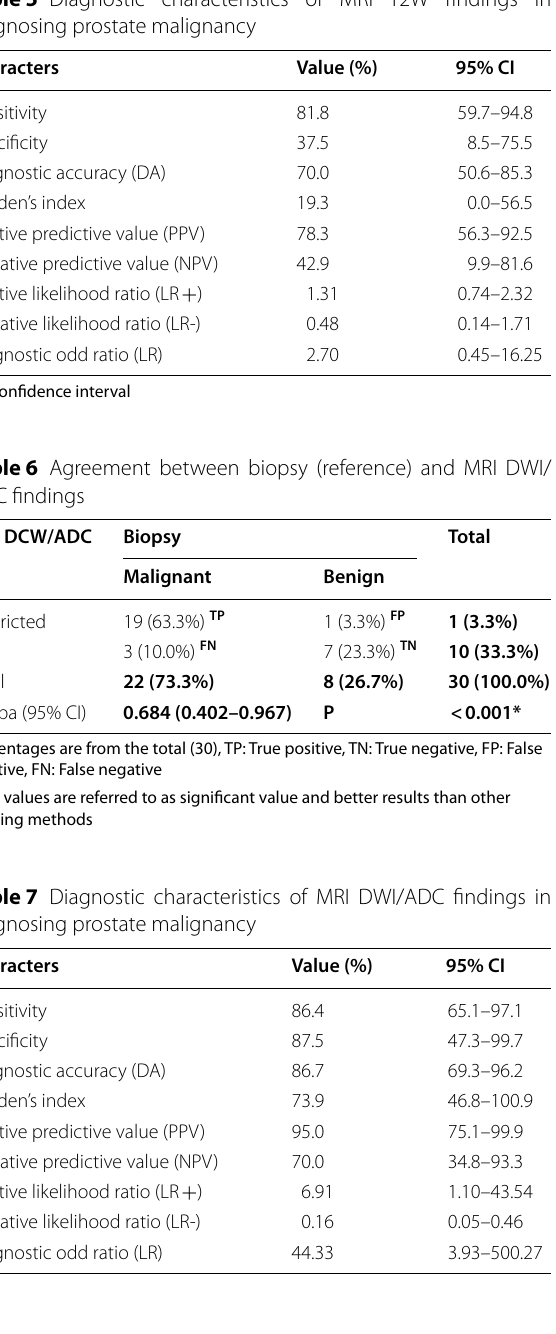
Table 5 Diagnostic characteristics of MRI T2W findings in